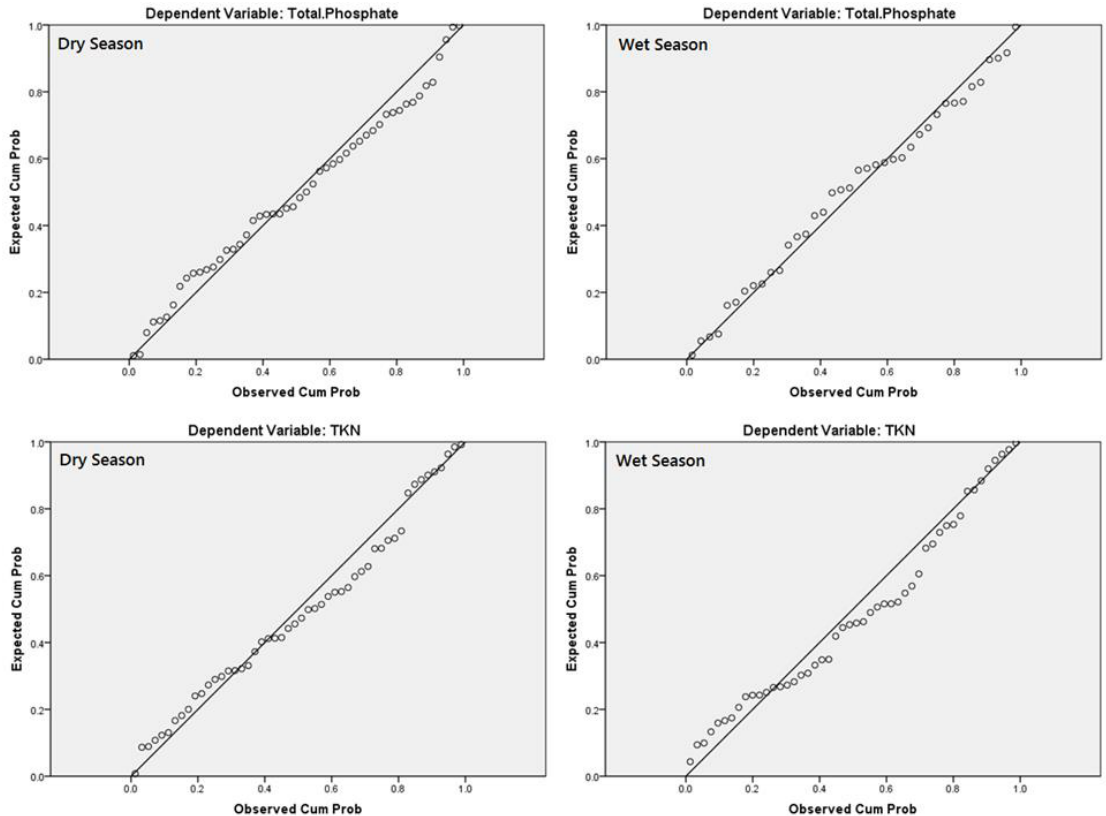
Figure 5. The normal probability–probability (P-P) plots of regression standardized residuals for TP and TKN in dry and wet seasons.